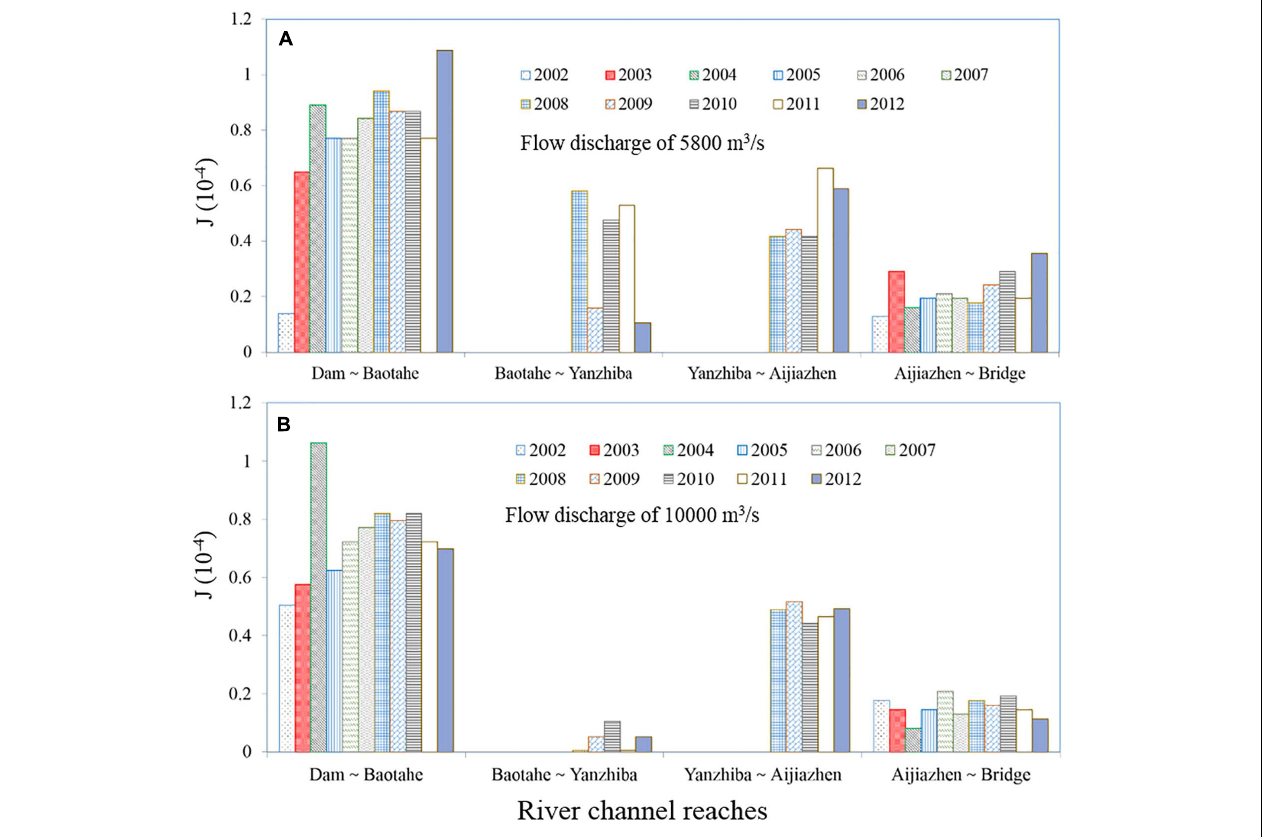
FIGURE 8 | Water surface gradient variation of each section in the Yichang reach at two different flow discharges: (A) 5,800 m 3 /s; (B) 10,000 m 3